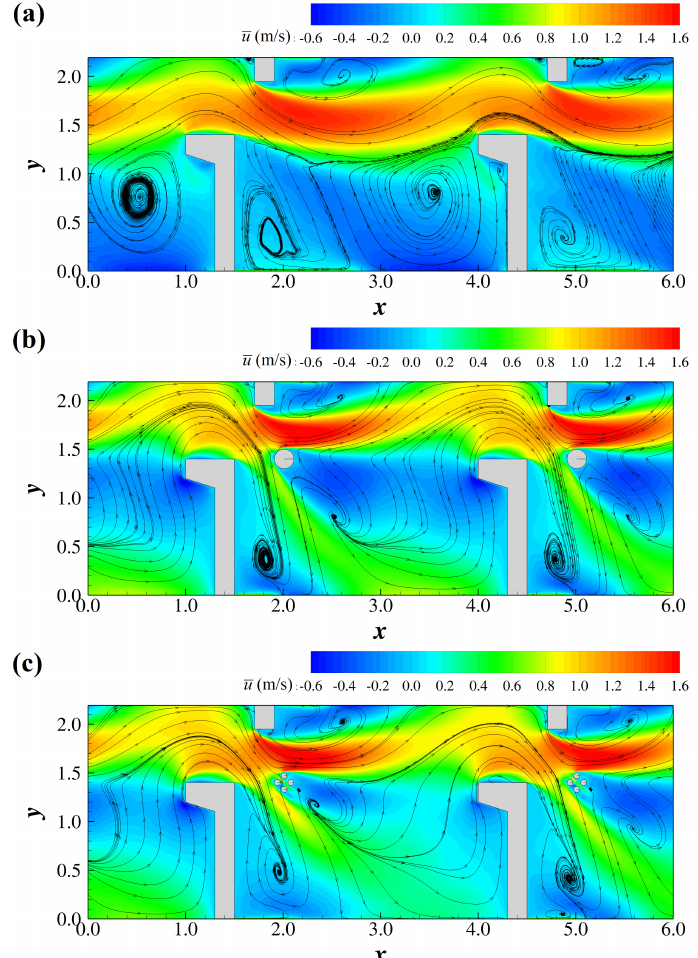
Figure 5. Distributions of time-averaged streamwise velocity with streamlines at the half height of: ( a ) Case1; ( b ) Case 2; ( c ) Case